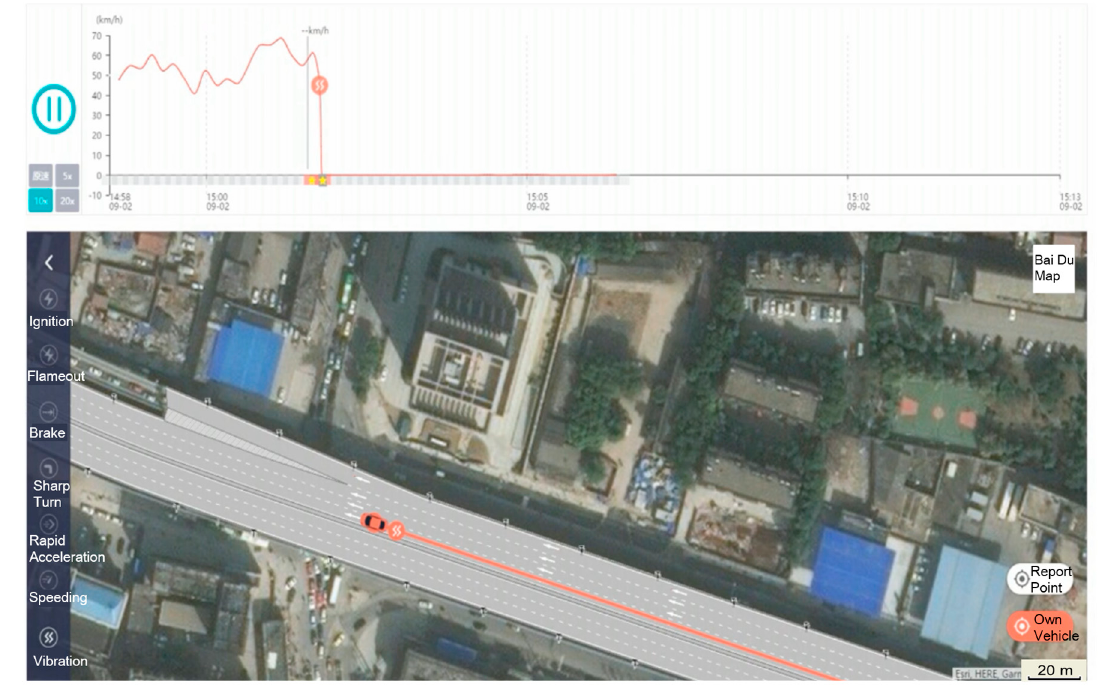
Figure 13. Accident simulation video.